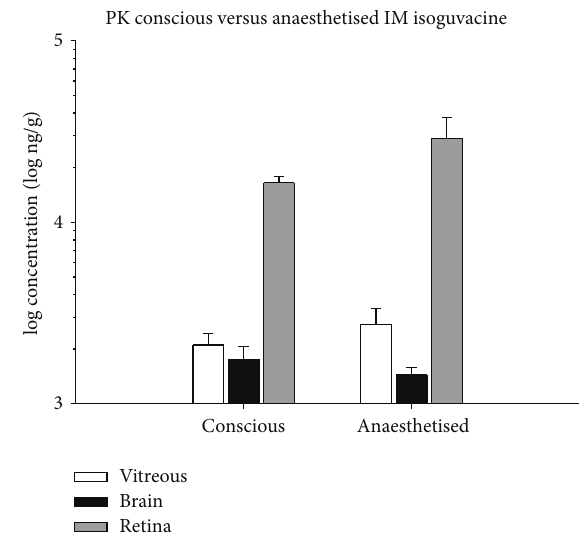
Figure 5: Pharmacokinetic analysis for IM injection of isoguvacine in conscious versus anaesthetised rats. Average ± SEM concen- tration (log ng/g) of isoguvacine in the vitreous (unfilled), brain (black), and retina (grey) 1.5 hours following IM administration of 30 mg/kg isoguvacine in conscious versus anaesthetised (ket: xyl) rats ( 𝑛 = 5 for each